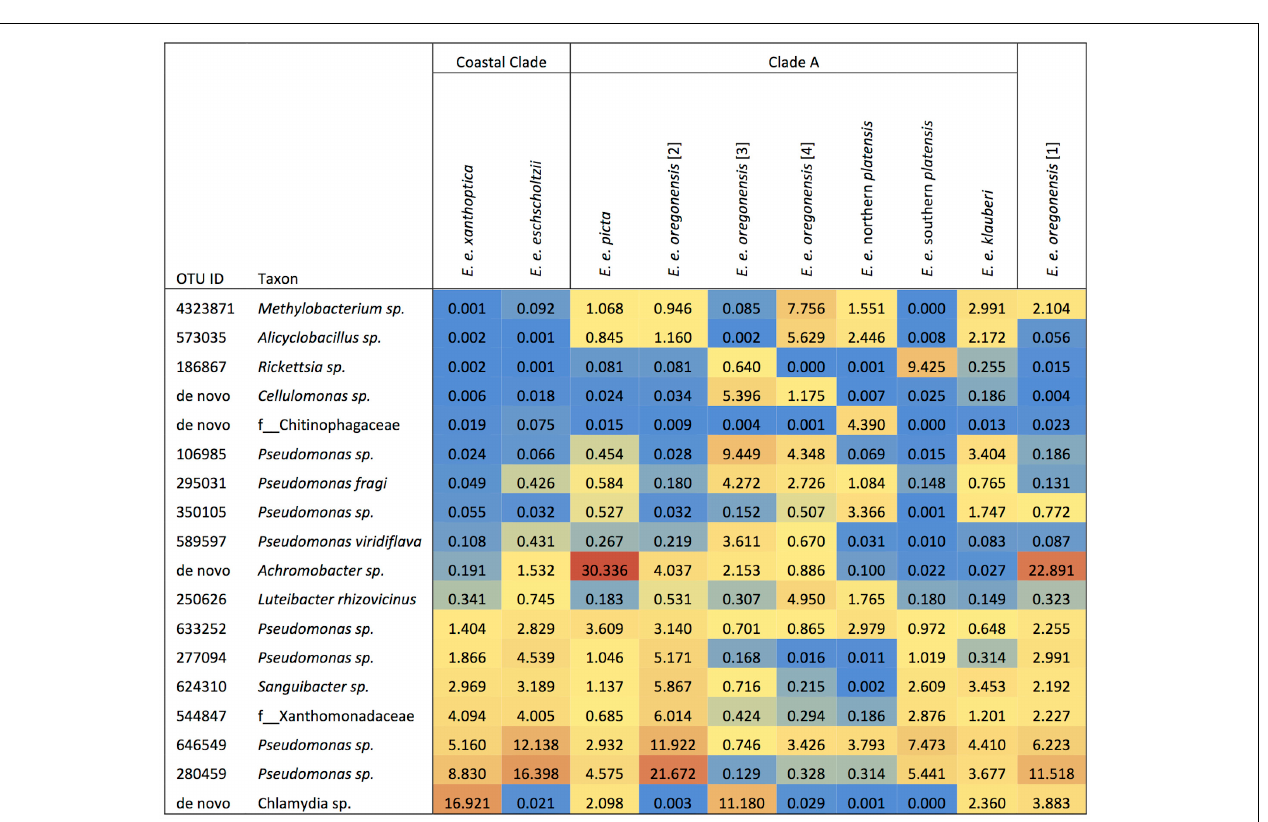
FIGURE 4 | Heat map of the relative abundances as percent values of dominant OTUs ( > 3% of microbiome composition within sample group) for each Ensatina